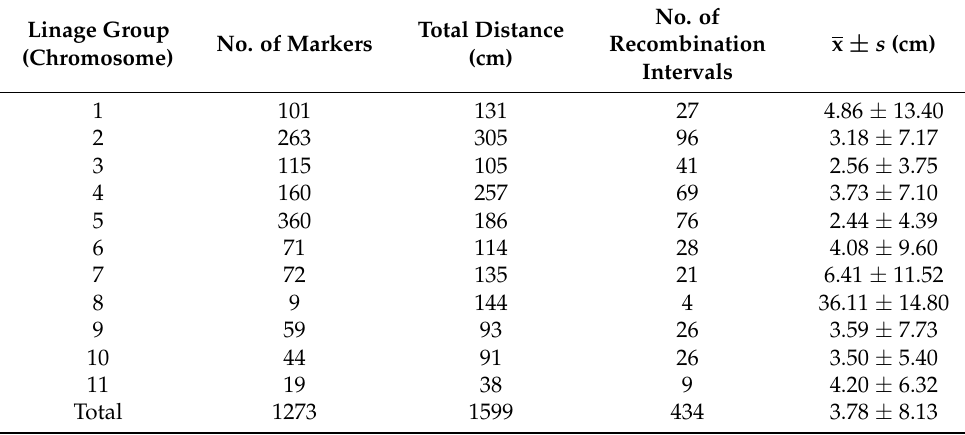
Table 1. Number of markers on the linkage groups (chromosomes). Linage Group (Chromosome)